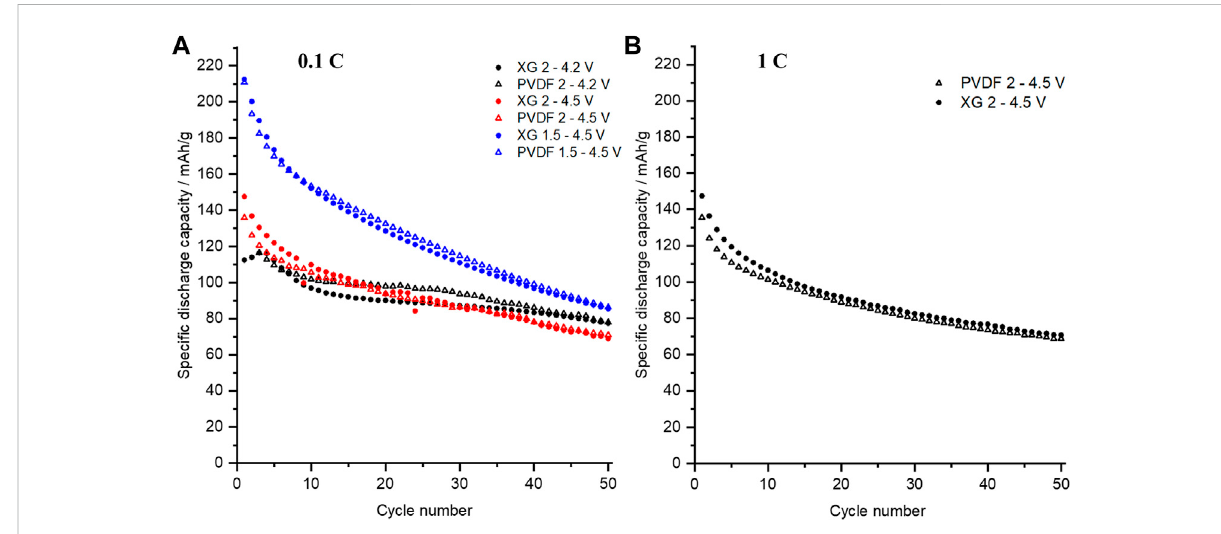
FIGURE 4 Cycling performance on P3-NNM with either the XG or PVDF binder (A) cycled at different voltages at 0.1 C and (B) at 1